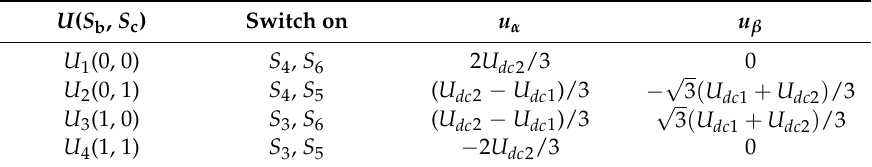
Table 1. Voltage vectors of fault-tolerant bidirectional voltage source converter (BVSC) with phase a fault.